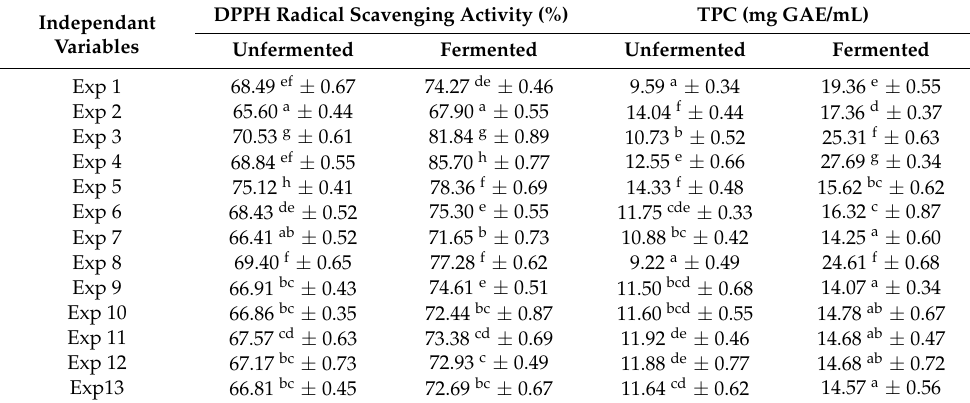
Table 4. DPPH radical scavenging activity and total phenolics content measured before and after KLB